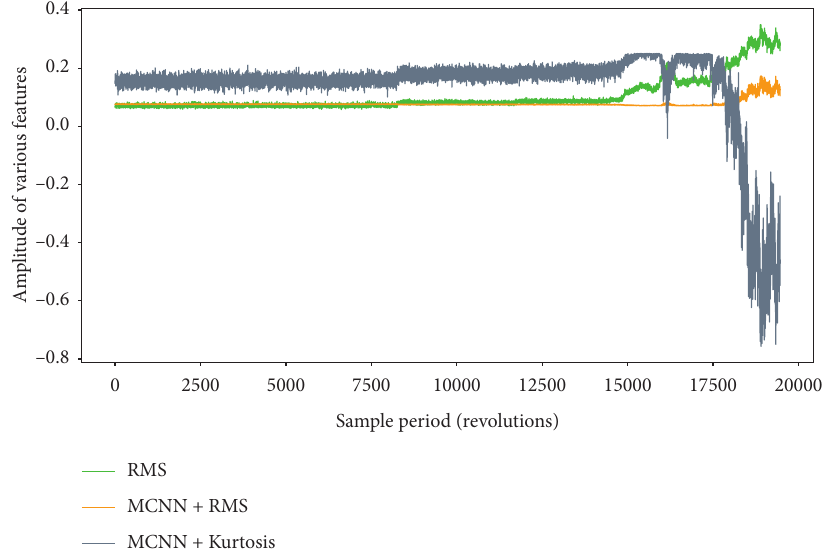
Figure 15: Comparison of RMS, MCNN+RMS, and MCNN